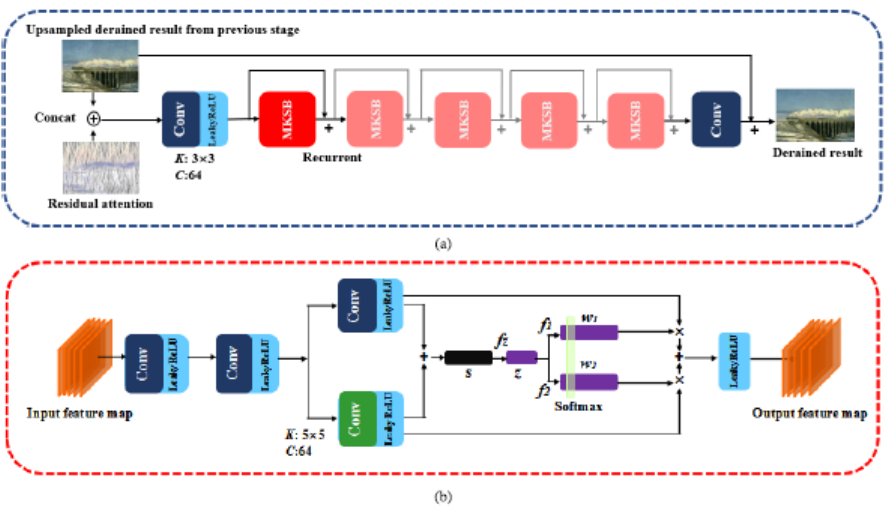
Figure 4. Schematic of the method by Zhang et al. [85]. The ( a ) shows the MSKSN model, and ( b ) shows the MKSB